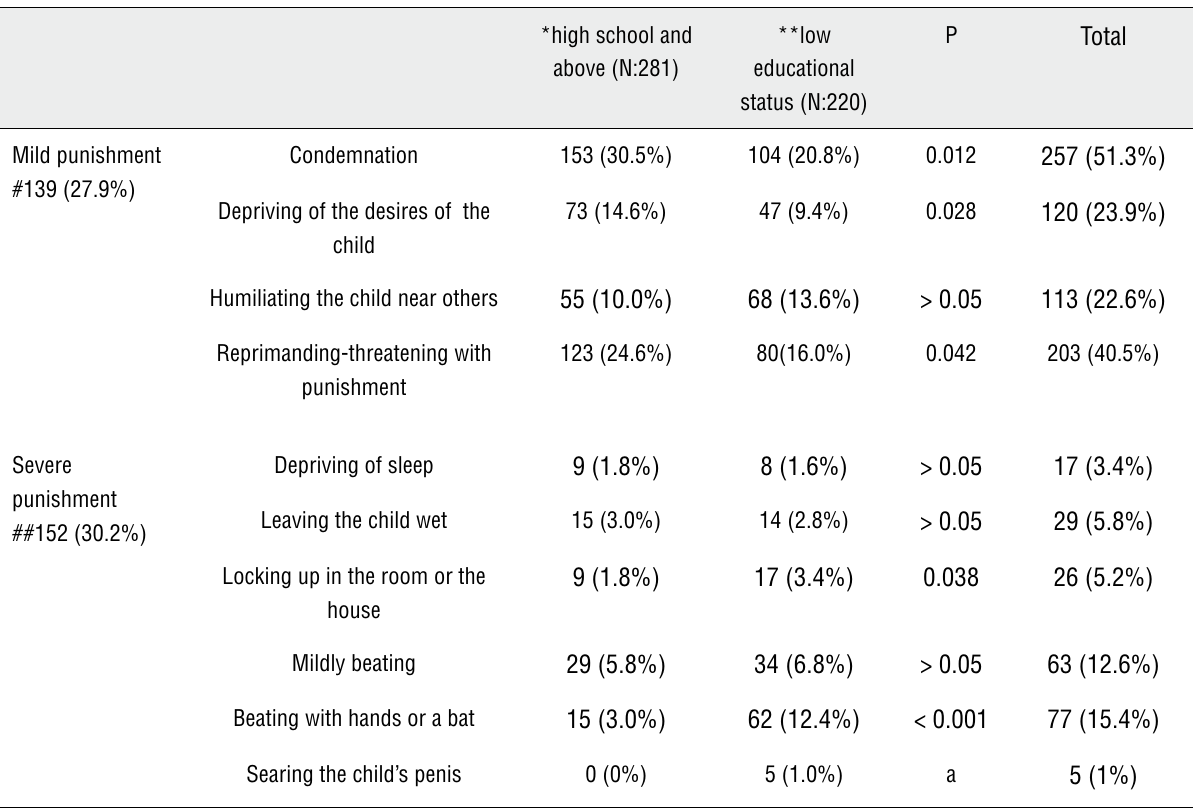
Table 2 - Distribution of punishment methods implemented by parents.